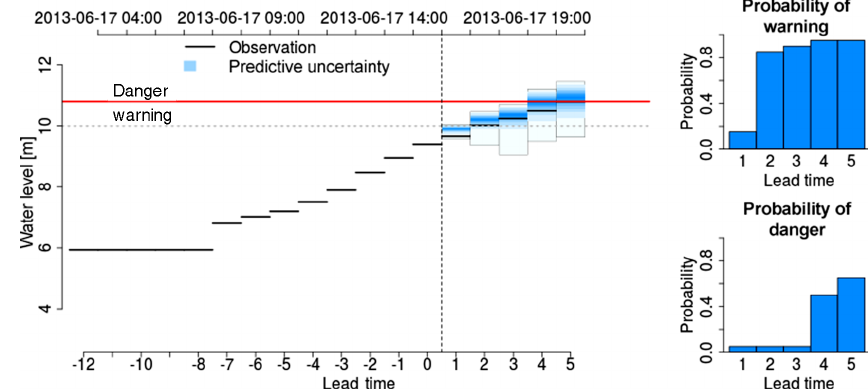
Figure 6. Forecast issued at 16:00LT 17 June 2013. Shown on the left are the predictions of future water level (blue) and observed data (black). On the right the probability of crossing the respective warning levels at each lead time is shown.